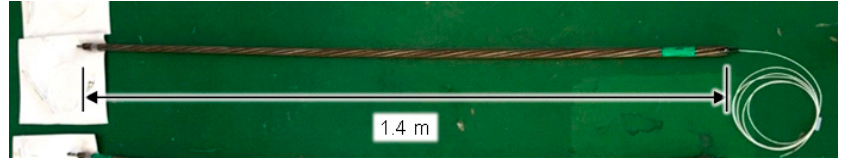
Figure 12. Specimen used in the tension test of a smart strand embedding the FBG sensor as proposed in this study.